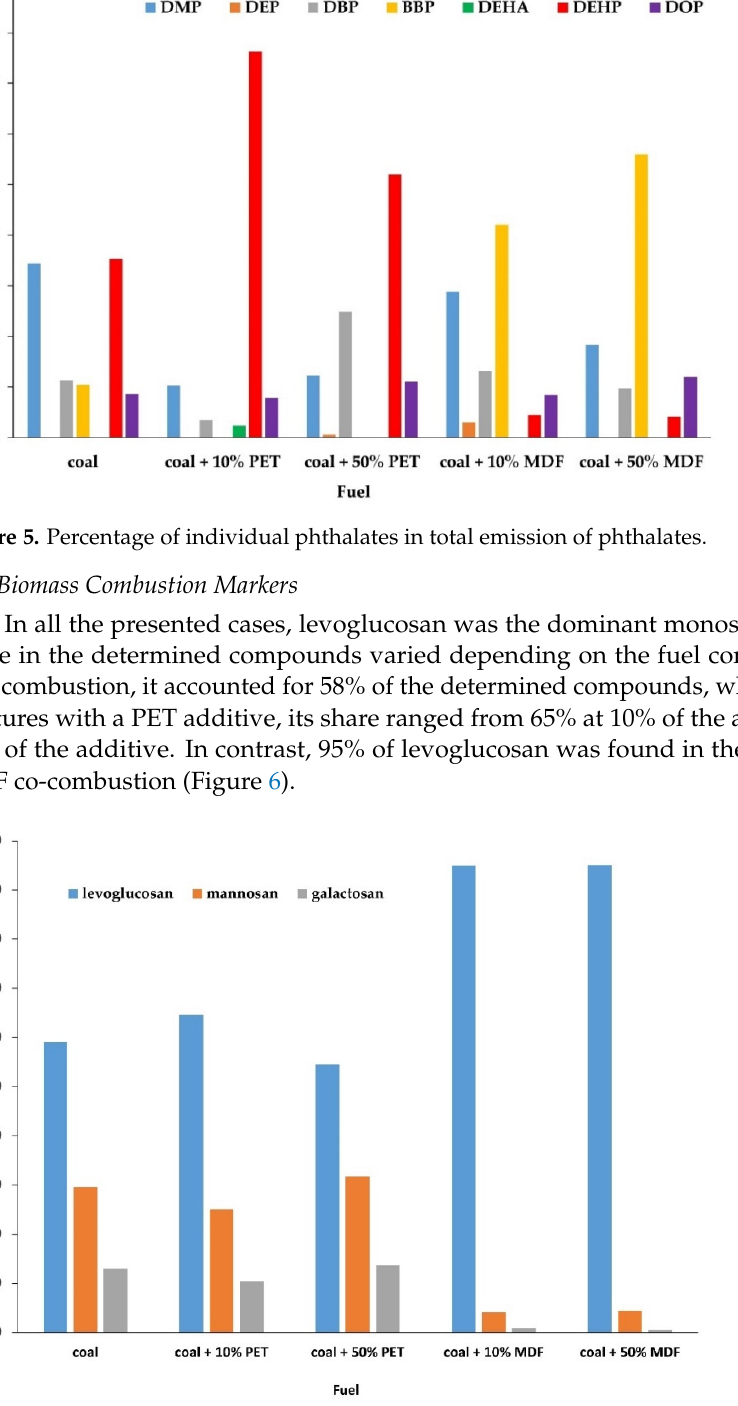
Figure 4. Percentage distribution of alkylphenols across the studied phases.